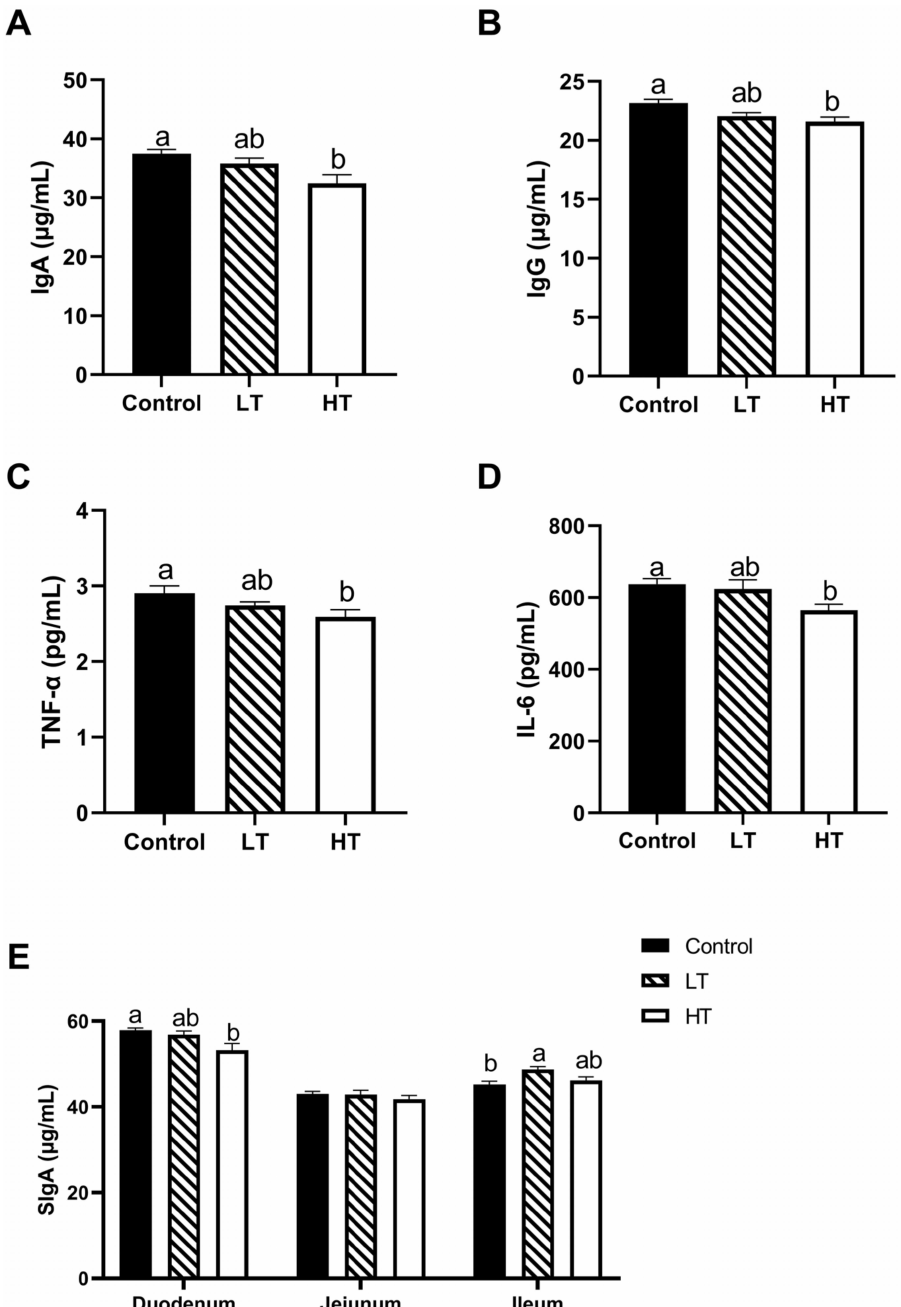
Figure 3. Effect of TA on cytokine and immunoglobulin of Brandt’s voles. Plasma levels of lgA ( A ), lgG ( B ), TNF- α ( C ), and IL-6 ( D ). SlgA levels of duodenum, jejunum, and ileum ( E ).